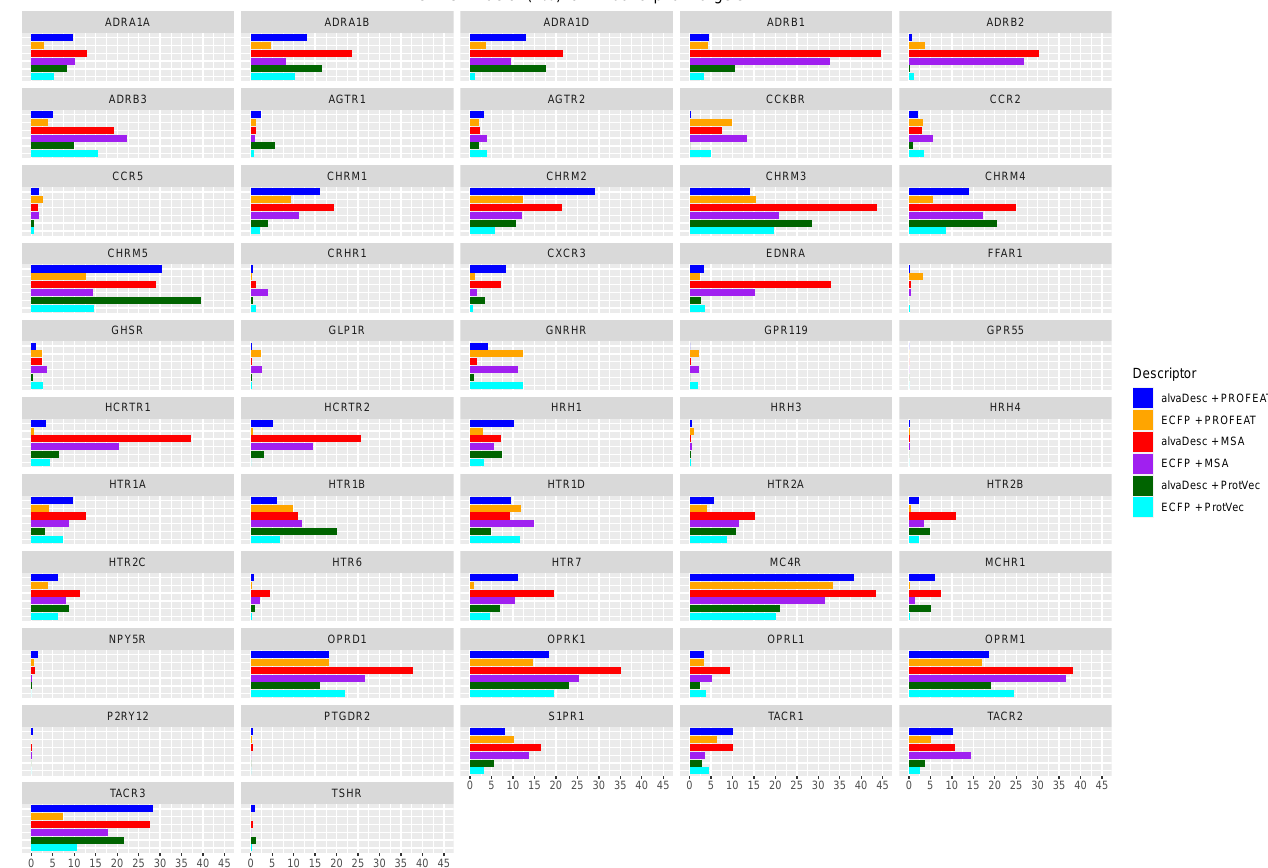
Figure 3. EF 1% of the screening calculation results using the virtual orphan GPCR models. Red, blue, and green bars indicate the combination of alvaDesc with MSA, PROFEAT, and ProtVec, respectively. Purple, orange, and light blue bars indicate the combination of ECFP with MSA, PROFEAT, and ProtVec,